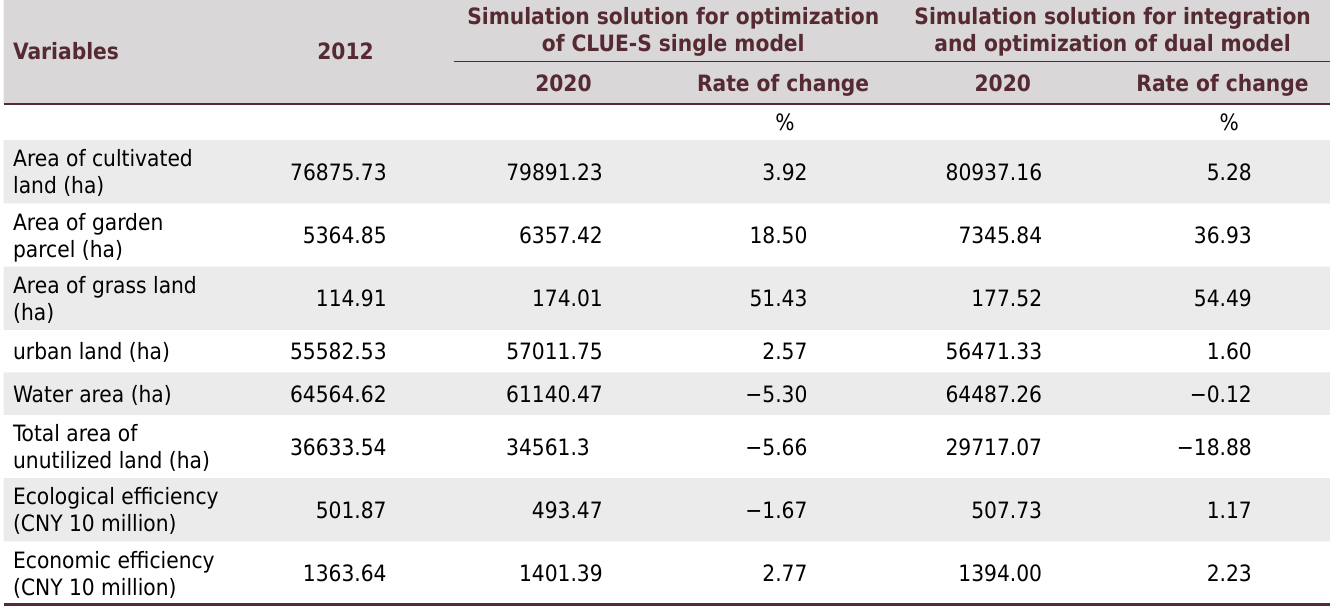
Table 8. Comparison of optimization simulations between the CLUE-S single model and the multi-objective integrated MOP and CLUE-S model